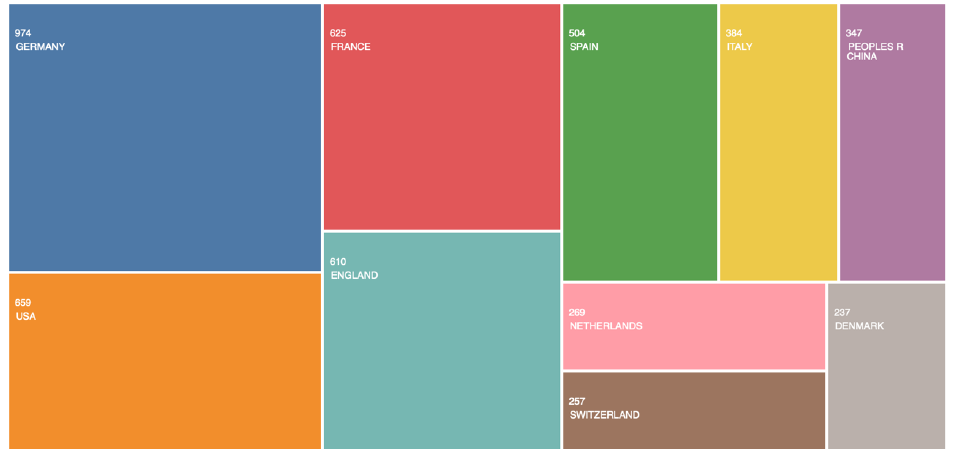
Figure 1. Chart presenting some of the countries of authors of publications relevant to the “nanophotonics” topic, according to a search in Clarivate Web of Science™; the search was refined by including only the 28 countries of European Community, plus Switzerland and the UK, in the “Countries/Regions” field. Here, only the countries with greater numbers of publications are shown. Since co-authors of a same publication may be affiliated with institutions in different countries (even outside Europe), the total of the numbers in the chart is greater than the number obtained from the refined search. Note: The areas on the chart are not strictly proportional to the values of each entry.